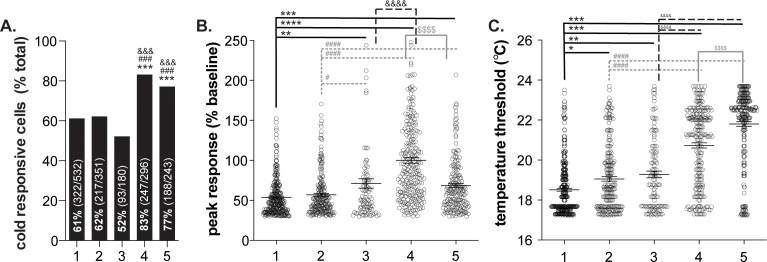
Variability in human keratinocyte responses to temperature decreases.In vitro calcium imaging was performed on primary human breast skin keratinocytes isolated from females of the following ages (years): 1: 41, 2: 50, 3: 54, 4: 52, 5: 49. (A).). Samples 4 and 5 contained the most cold-responsive cells (Chi-square: p<0.0001; Fisher’s Exact tests: ***p<0.001 vs. sample 1, ### p<0.001 vs. sample 2, &&& p<0.001 vs. sample 3). (B).) Peak calcium responses differed between the samples; keratinocytes from sample four exhibited the largest calcium response during cold stimulation (100% increase over baseline. Mean increase for sample 1: 54%, 2: 57%, 3: 71%, 5: 68% (1-way ANOVA p<0.0001; Bonferroni’s multiple comparisons: **p<0.01, ***p<0.001, ****p<0.0001 vs. 1; # p<0.05, #### p<0.0001 vs. 2; &&&& p<0.0001 vs. 3; $$$$ p<0.0001 vs. 4). (C).) The temperature at which keratinocytes responded to cold (>30% increase in Δ340/380) differed between the samples. Mean temperature thresholds (°C) for sample 1: 18.5, 2: 19.1, 3: 19.2, 4: 20.7, 5: 21.8 (Kruskal-Wallis test p<0.0001; Dunn’s multiple comparisons: *p<0.05, **p<0.01, ***p<0.001 vs. 1; ### p<0.001 vs. 2; &&&& p<0.0001 vs. 3; $$$$ p<0.0001 vs. 4).